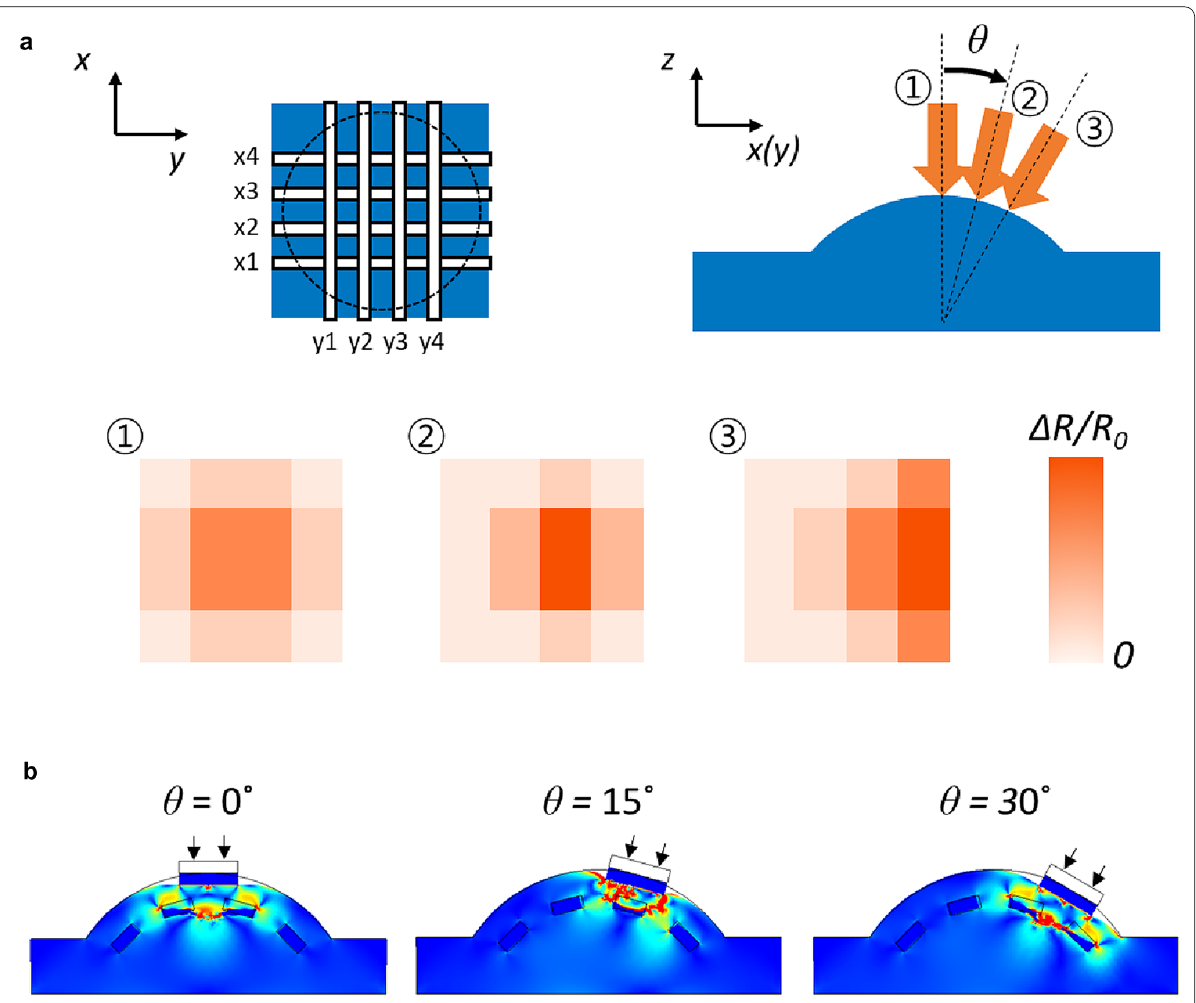
Fig. 2 Working principle of the proposed sensor. a Multi-layer liquid metal microchannels in x (x1, x2, x3, and x4) and y (y1, y2, y3, and y4) direction and different loading directions in x(y)-z plane. Different responses of the sensor array with respect to the loading direction ( ① , ② , and ③ ). b Finite element analysis (FEA) simulation results showing the corresponding deformations of the liquid metal